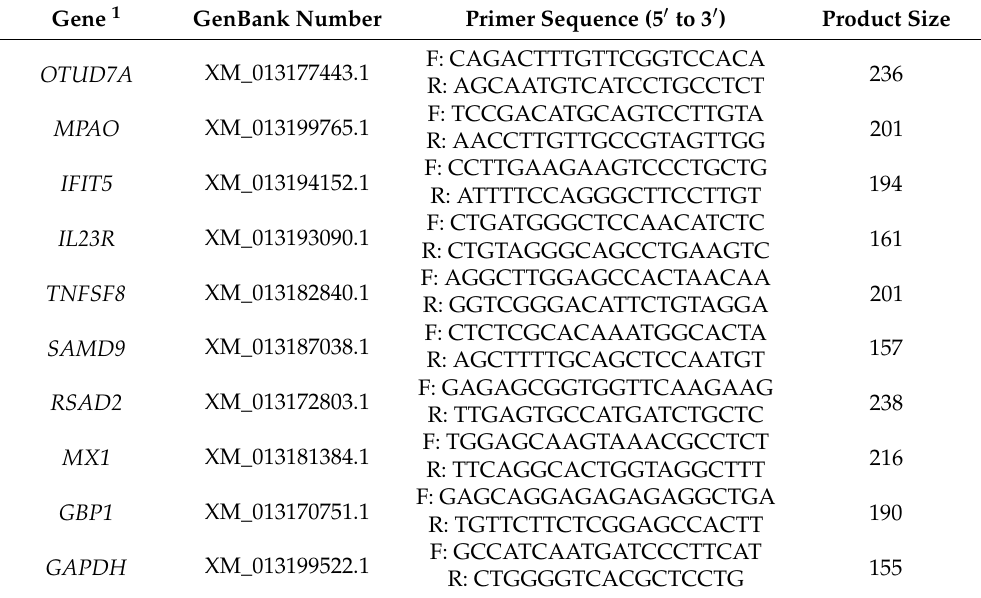
Table 1. Primer sequences for real-time quantitative PCR